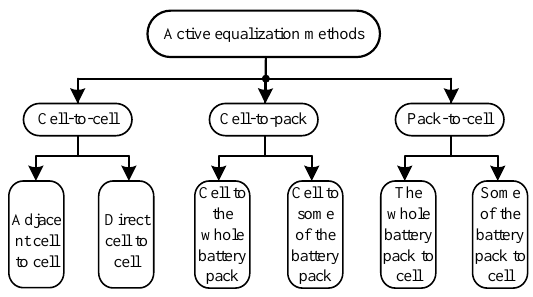
Figure 1. Classification of active equalization methods.